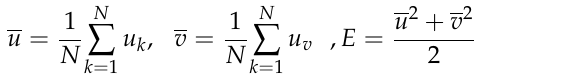
Figure 17. Mean kinetic energy.